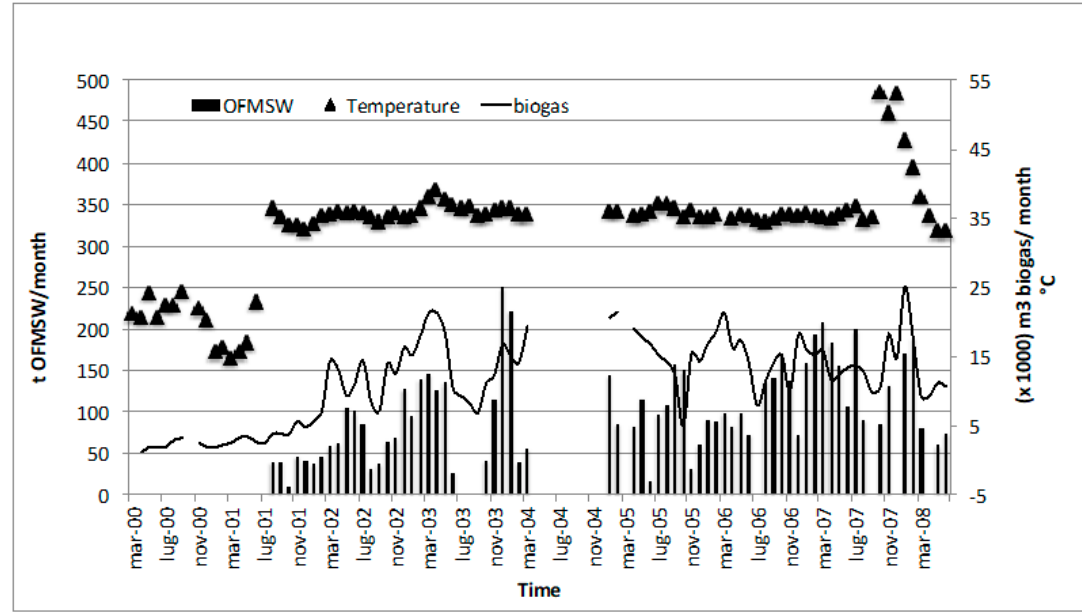
Figure 2. Amount of organic waste treated per month, average biogas production per month, working temperature behavior (Treviso wastewater treatment plant